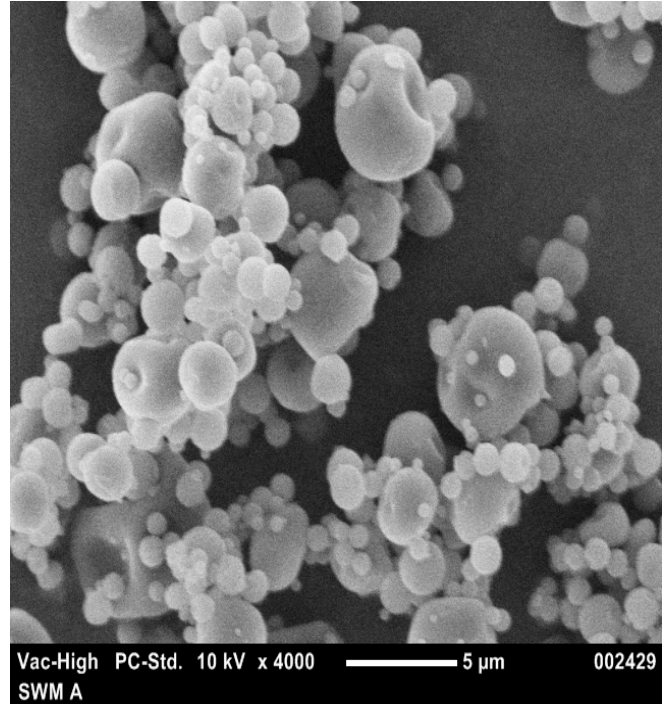
Figure 2. SEM photomicrograph of AmB spherical amorphous solid dispersions.